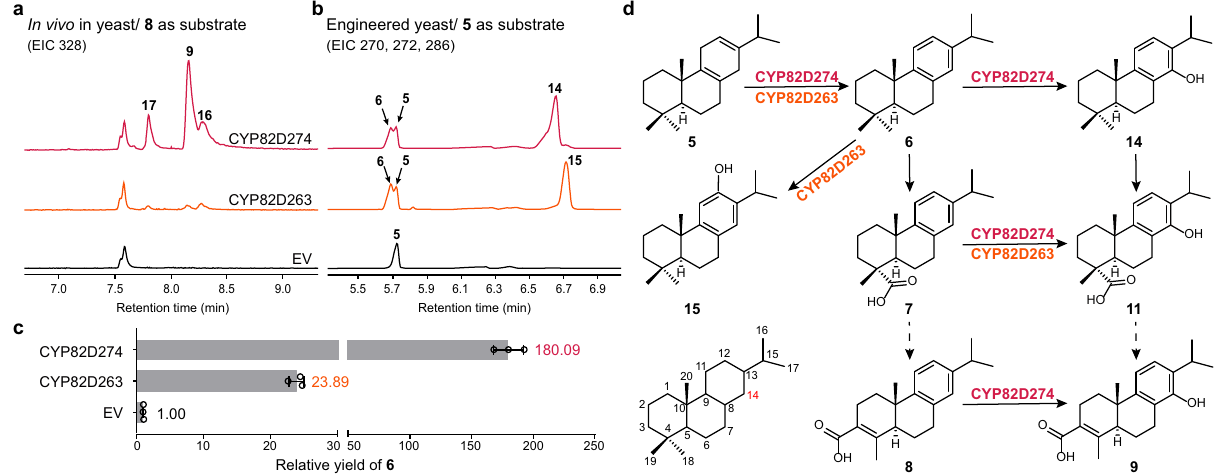
Fig. 5 | Metabolic grid of C-14 hydroxylation and aromatization. a GC ‒ MS ana- lysis of methylated products with triptobenzene D ( 8 ) as the substrate. b GC ‒ MS analysis of the catalytic products of miltiradiene ( 5 ) in engineered yeast. The mass spectrum results are shown in Supplementary Figs. 12 and 13. c Relative yield of abietatriene ( 6 ) in spontaneous, CYP82D274 and CYP82D263 cultures. Data are